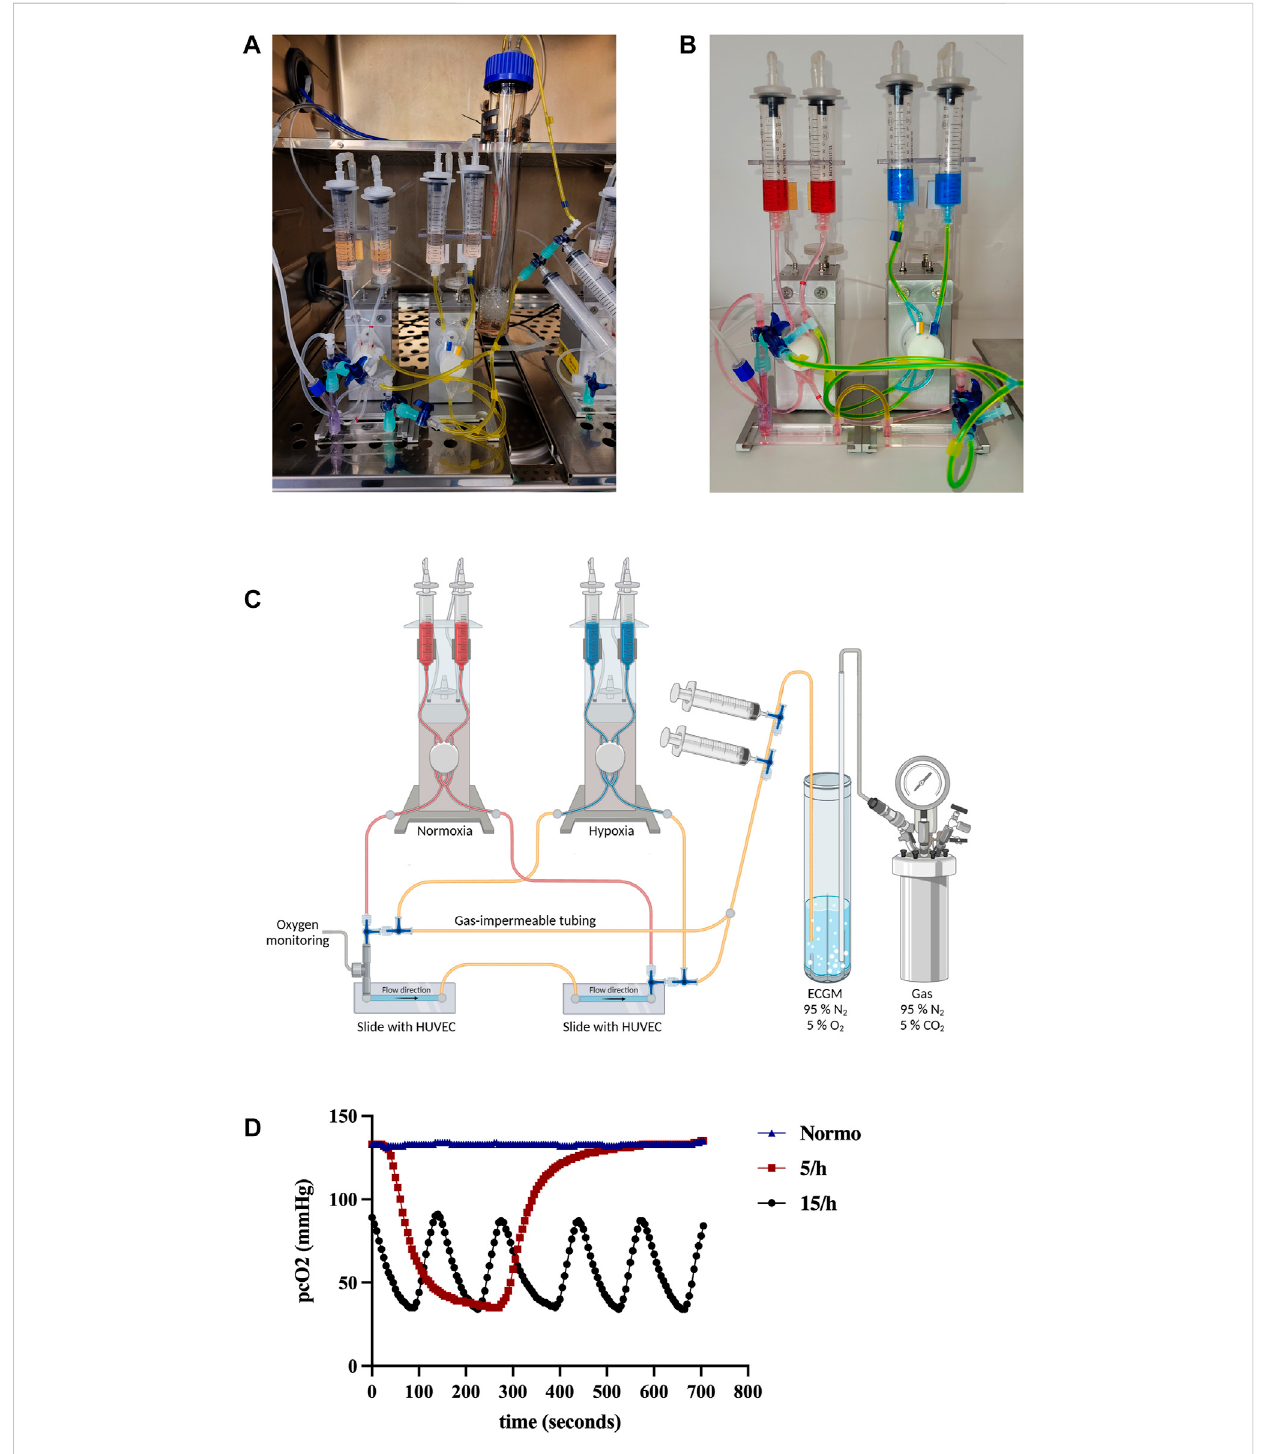
FIGURE 1 Introducing anovel model ofintermittenthypoxiainendothelial cells under fl owsimulatinghallmarksofOSA hypoxic pathophysiology. Wesetup a novel model re fl ecting the in vivo measured hypoxic desaturation characteristics (time course, frequency and target oxygen concentration). (A) Experimental overview of the novel model under cell culture conditions in the incubator (A) , in detail (B) and as schematic illustration (C) : Desaturated mediumisillustratedbybluecolor,normalmedium byredcolor.Themedium isconstantlydegassedinthebioreactorwith95%N 2 and5%CO 2 and intermittently loaded into the “ hypoxic ” fl uidicunit indicated by gas impermeable yellow tubing before each hypoxic cycle. Switching from normal to the hypoxic medium directed by different perfusion systems can be achieved by rotating the stopcock ’ s position (Supplementary Video S1). The endothelial cells can beperfused with thedegassed medium untilthe real-time oxygen measurement con fi rmsthe targeted oxygen partial pressure (Supplementary Video S2). Detailed partial pressure of oxygen on cellular level (pcO 2 ) over time measured by LiCox ® probe (D) . Shown are 5 subsequent hypoxia/ reoxygenation cycles in the 15/h group and 1 cycle in the 5/h group, while the normoxia group stayed on atmospheric oxygen partial